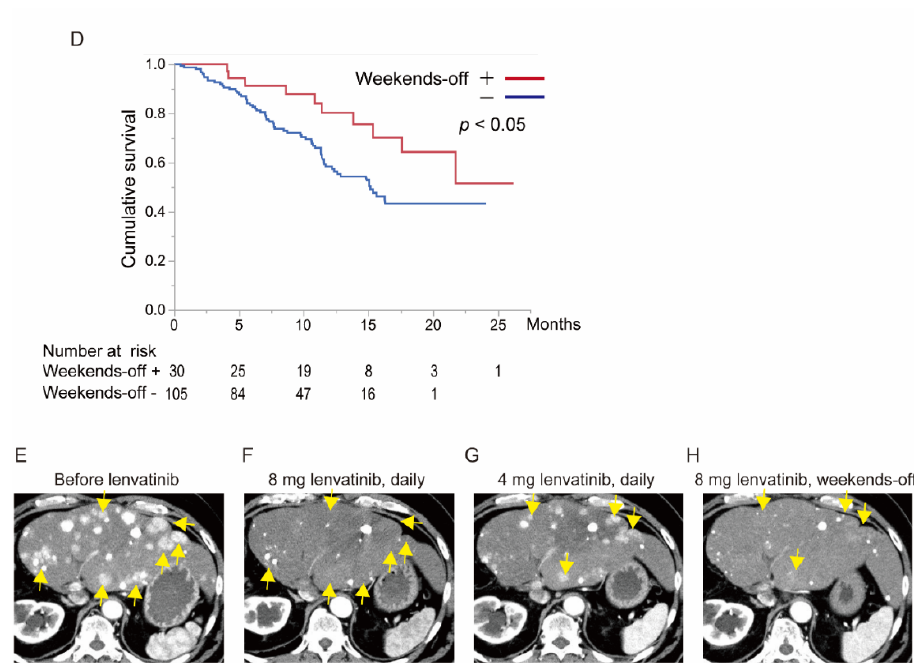
Figure 4. Assessment of the weekends-o ff administration of lenvatinib. ( A ) Tolerability toward adverse events (AEs) (66.7% of patients were tolerant to lenvatinib-induced AEs). ( B ) Therapeutic response according to the type of lenvatinib protocol. The disease control rate (DCR) of patients treated with lenvatinib at the initial daily dose was 93.3%. After dose reduction due to the appearance of adverse events, the DCR was reduced to 19.2%. After switching to the weekends-o ff protocol, the DCR increased to 61.5%. ( C ) Duration of lenvatinib administration in 30 patients treated using the weekends-o ff protocol (red line) and 105 patients treated using the continuous daily administration protocol (blue line). The median administration period of patients who were treated with the weekends-o ff protocol was significantly longer than that of patients treated with the continuous protocol ( p < 0.001). ( D ) The survival curve of patients treated with lenvatinib. The red line shows the survival curve of patients who followed the weekends-o ff protocol and the blue line shows the survival curve of patients who followed the standard (continuous daily administration) protocol. The median survival time (MST) of patients who followed the standard protocol was 15.2 months, while > 50% of the patients who received the weekends-o ff protocol of lenvatinib survived for at least 20 months, and their follow-up is continuing. The MST of patients who followed the weekends-o ff protocol of lenvatinib was significantly longer than that of patients who followed the standard protocol ( p < 0.05). ( E – H ) Representative computed tomography (CT) images of patients who received weekends-o ff administration of lenvatinib. ( E ) CT image before administration of lenvatinib. Multiple enhanced lesions are shown (arrows). ( F ) CT image after 8 mg of lenvatinib once daily. Enhancement of most lesions disappeared (arrows). ( G ) CT image after dose reduction to 4 mg of lenvatinib once daily. Most lesions showed re-enhanced vascularity (arrows). ( H ) CT image after weekends-o ff administration of lenvatinib. Tumor vascularity was reduced again (arrows). Abbreviations: AEs, adverse events, CR, complete response, CT, computed tomography, DCR, disease control rate, PD, progressive disease, PR, partial response, SD, stable disease, MST, median survival